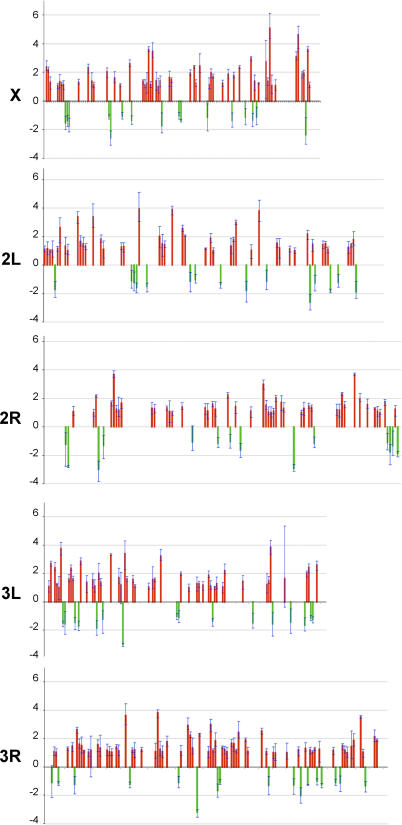
Genes That Exhibit Altered Expression in ISWI Mutants Are Broadly Distributed throughout the GenomeThe positions of euchromatic genes that exhibit a 2-fold or greater change in expression in the salivary glands of Iswi mutant males are shown. The x-axis corresponds to the relative cytological positions of genes on the X chromosome (X) and the left or right arms of the second (2L and 2R) and third (3L and 3R) chromosomes. Red and green bars mark genes that are repressed and activated by ISWI, respectively. The fold change in gene expression (log2) in Iswi mutants relative to wild-type is shown on the y-axis. The chromosomes are drawn to scale based on the amount of euchromatin found on each arm.